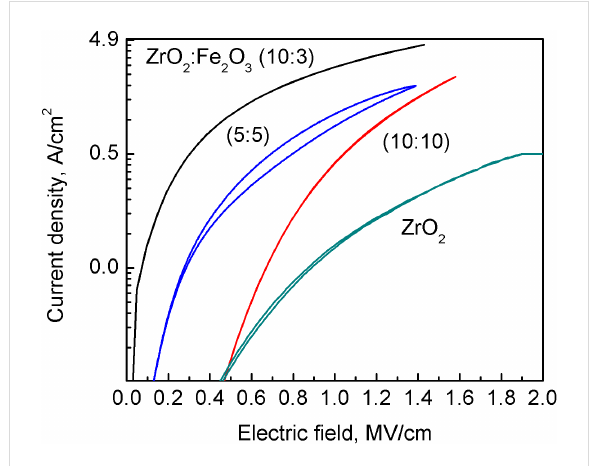
Figure 7: Current density–applied electric field curves for samples with ZrO 2 /Fe 2 O 3 cycle ratios shown in the